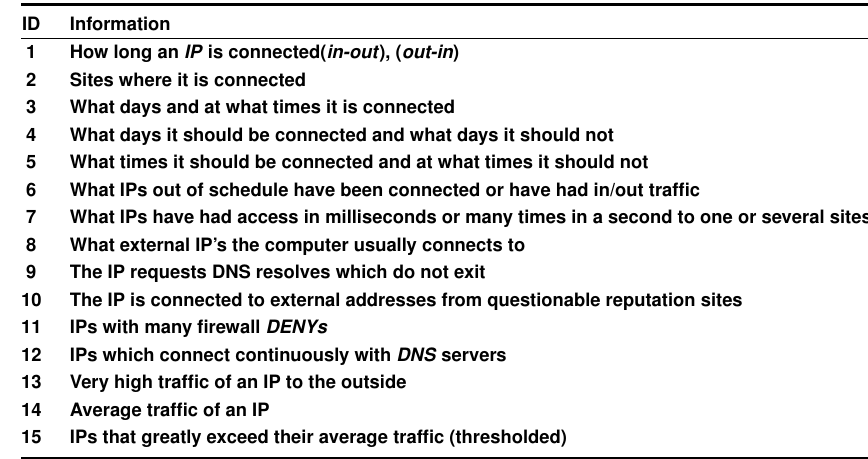
Table 2. Discriminant information to categorize malicious